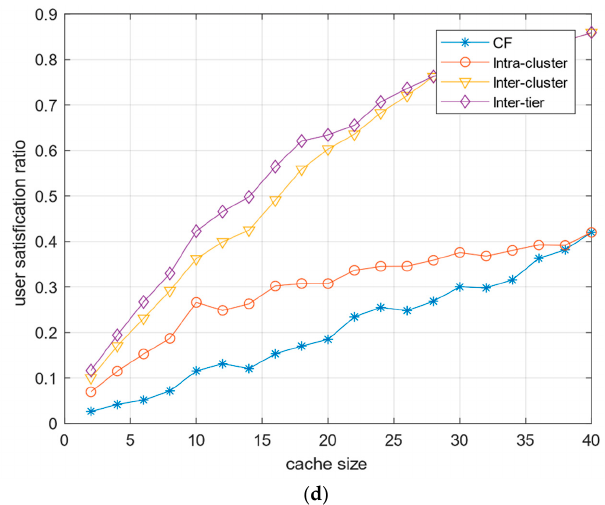
Figure 4. ( a ): User satisfaction rate versus cache capacity in pico cell (cluster1 of tier 1). ( b ): User satisfaction rate versus cache capacity in pico cell (cluster 2 of tier 1). ( c ): User satisfaction rate versus cache capacity in micro cell (cluster 1 of tier 2). ( d ): User satisfaction rate versus cache capacity in micro cell (cluster 2 of tier 2).